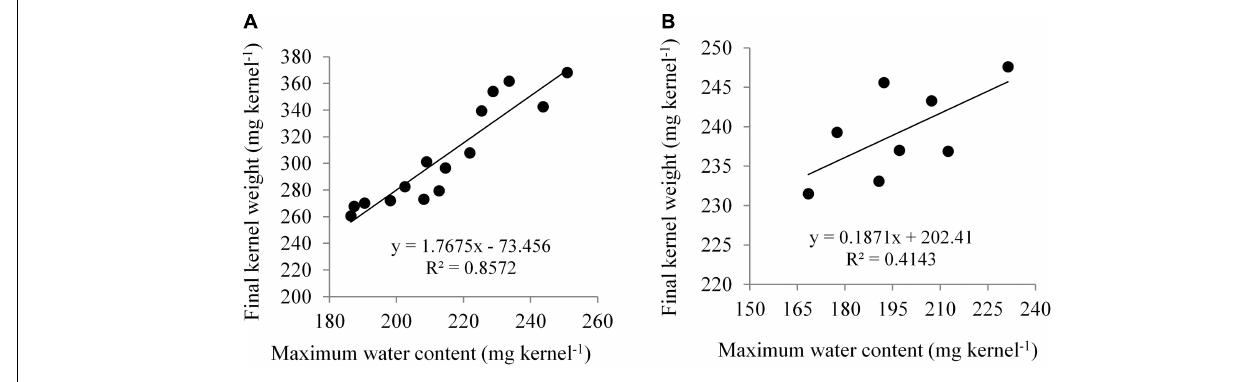
FIGURE 6 | Relationship between maximum kernel water content (MKWC) and final kernel weight (FKW) in Expt. 1 (A) and Expt. 2 (B) . TABLE 3 | Effect of water regimes on grain filling components of maize hybrids in Expt. 2.